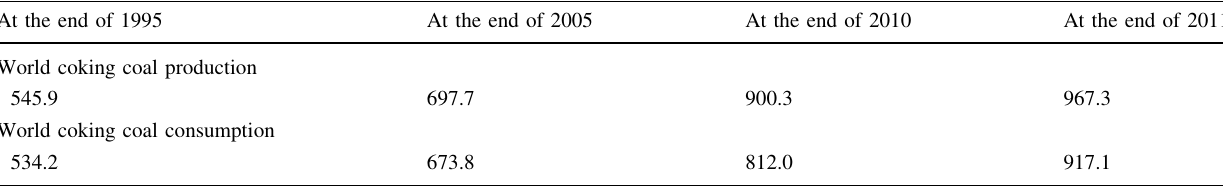
Table 3 World coking coal production and consumption, mln.tons (IEA 2012) At the end of